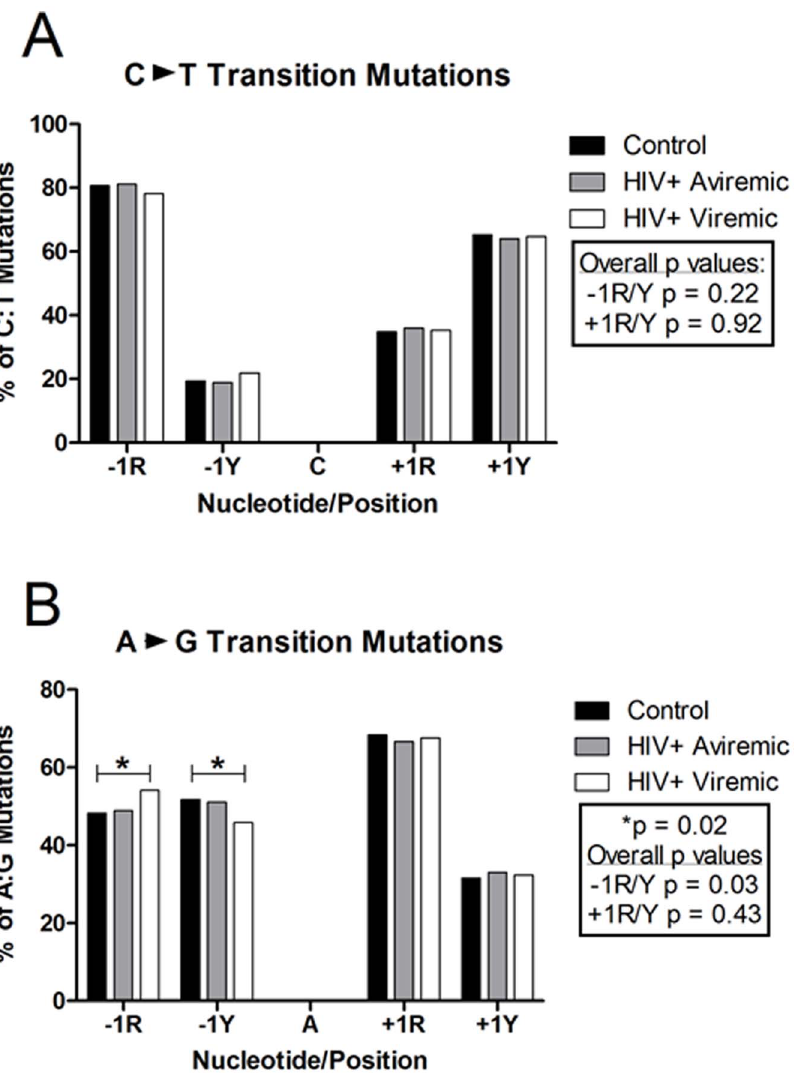
Figure 6. Dinucleotide analysis of C:T and A:G Transition mutations. The percent either of R (A or G) or Y (C or T) nucleotides occurring in either the 2 1 (5 9 ) position or the + 1 (3 9 ) position to a mutation were calculated. Medians are represented for the control (n=10; black bars), aviremic (n=6; gray bars), and viremic HIV-1-infected groups (n=15; white bars).